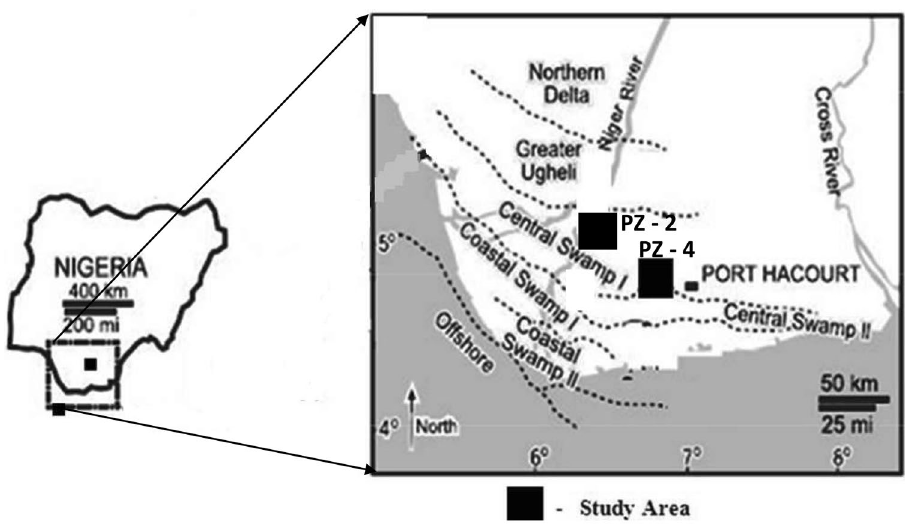
Fig. 1 Map of Niger Delta depobelts showing the location of the studied wells (Doust and Omatsola